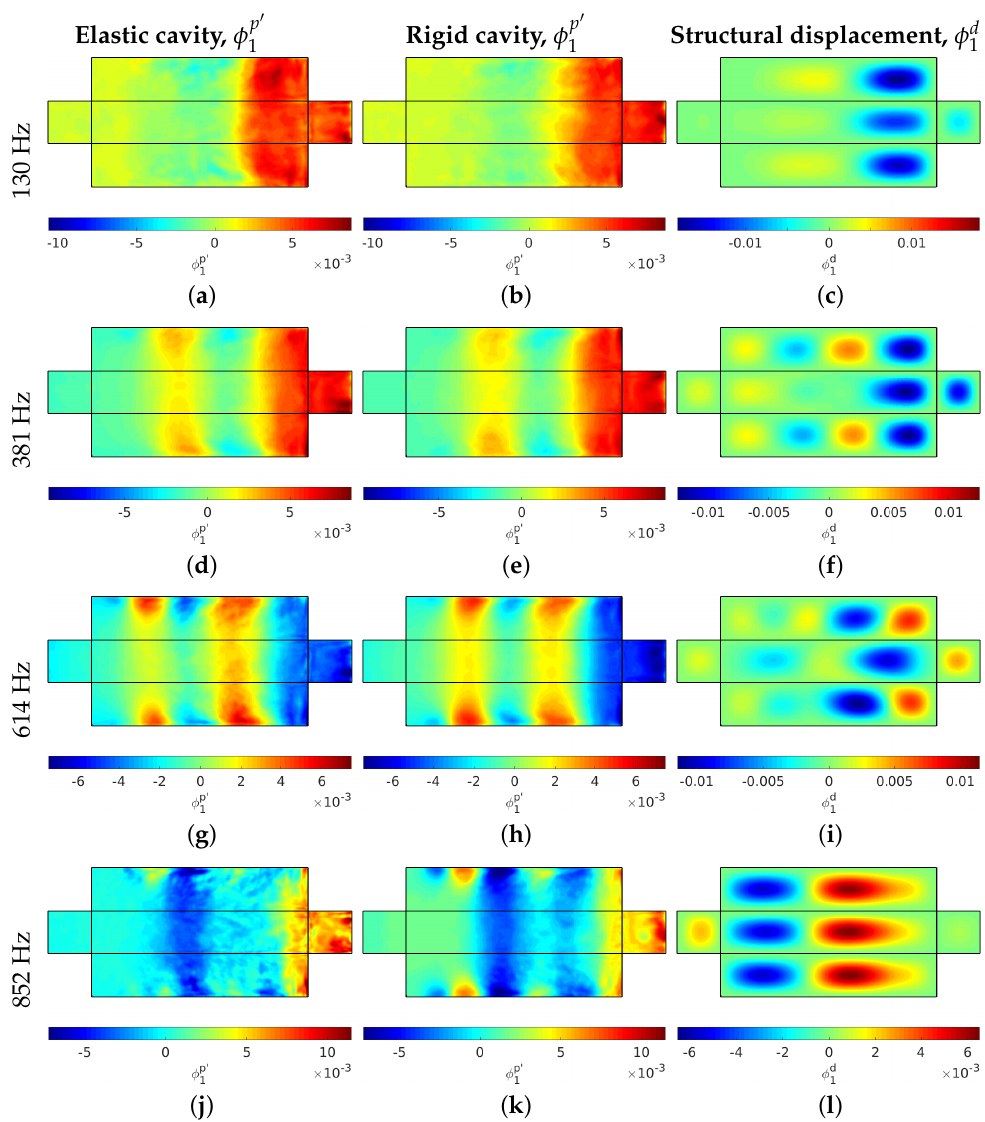
(cid:48) of the elastic cavity ( left column ), rigid 1 ( right column ) at the Rossiter 1